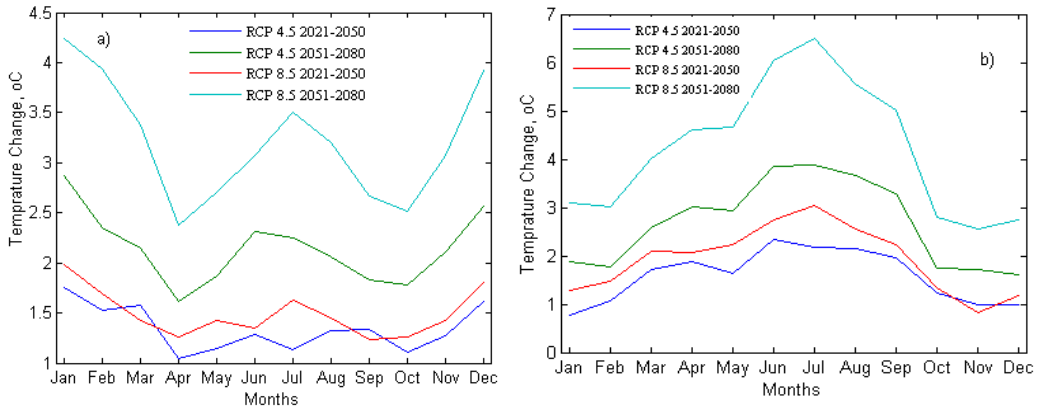
Figure 7. Seasonal projected change in mean maximum temperature ( a ) and minimum temperature ( b ) in Finchaa catchment for 2021–2050 and 2051–2080 under RCP4.5 and RCP8.5.